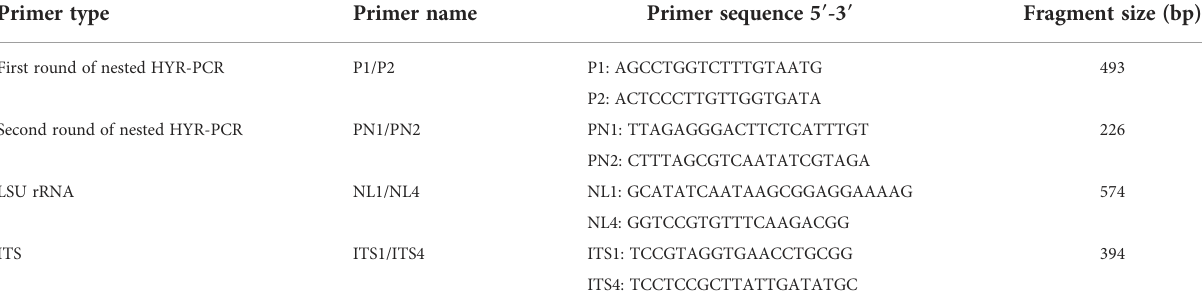
TABLE 2 Primer sequences and ampli fi ed product fragments.